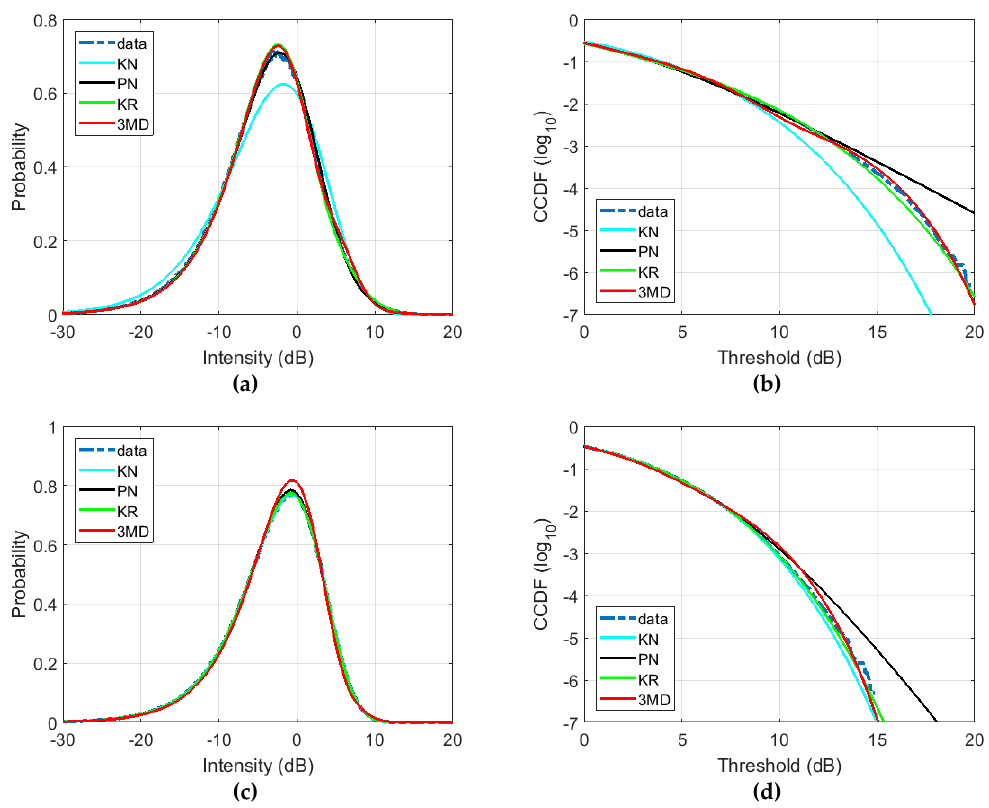
Figure 18. Amplitude distributions of the SETHI dataset, (Run 1), grazing angle 10 ◦ , wind speed 17 m/s. ( a ) HH polarization PDF, ( b ) HH polarization CCDF, ( c ) VV polarization PDF, ( d ) VV polarization CCDF. Table 9. Parameter estimates for the models in Figure 18.